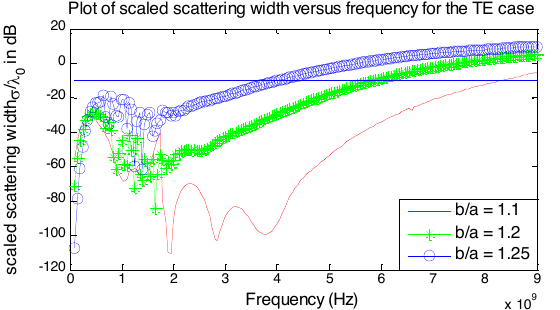
FIGURE 11. Normalized backscattering width (TE polarization) versus frequency of Rings and rods media coating with c/a = 1.3